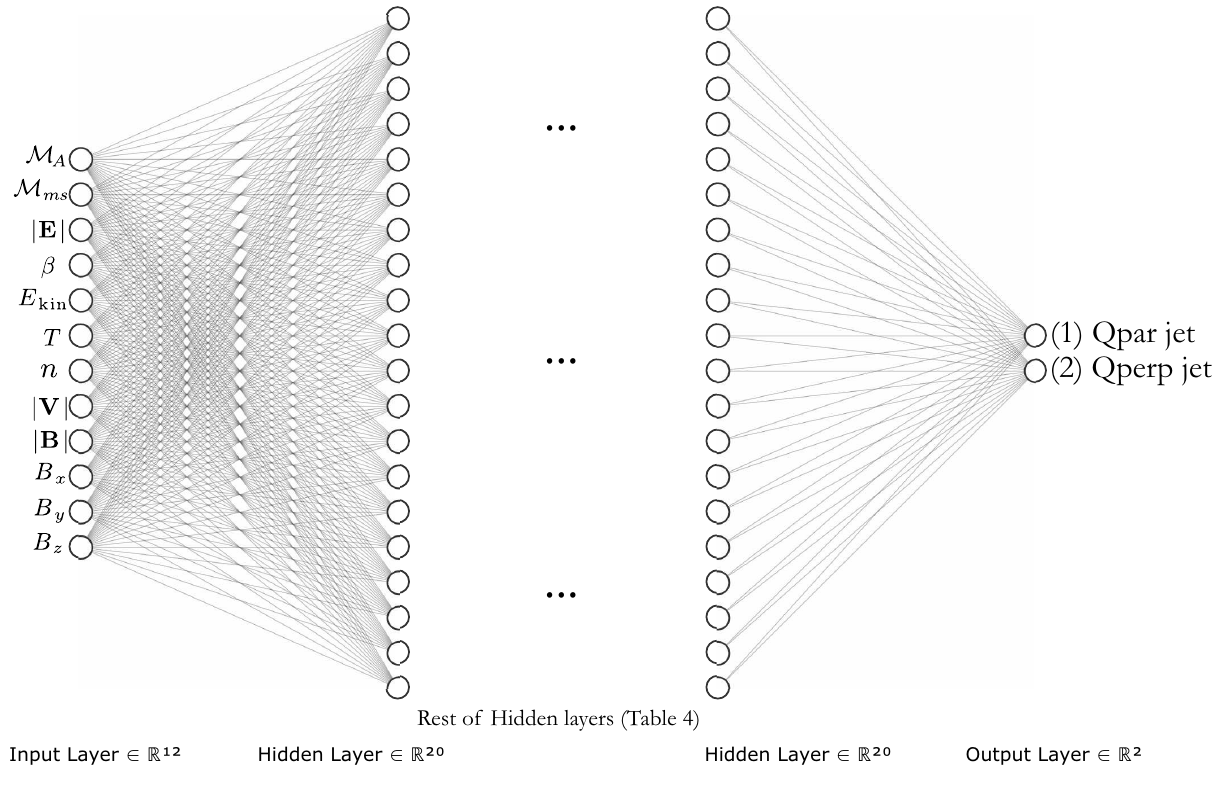
FIGURE 3 | Basic architecture of the neural network used for the classification of the jets. The input layer shows all the quantities that were used in the neural network method. To avoid having too many nodes and neurons shown, the rest of the hidden layers are given in Table 3 . The visualization was done by using a publicly available tool ( LeNail, 2019) and editing its output.